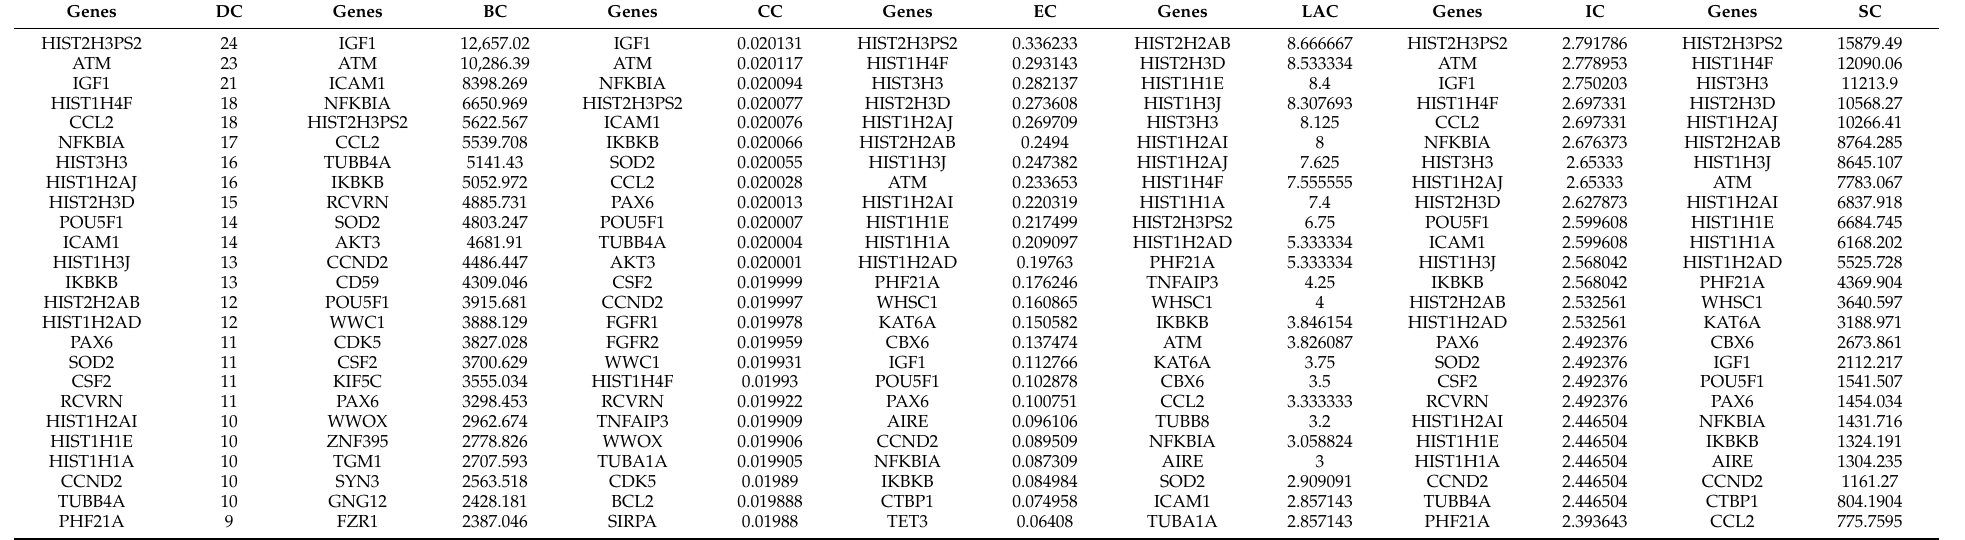
Table 3. Topological characteristics of target genes regulated by pseudogenes in the PPI